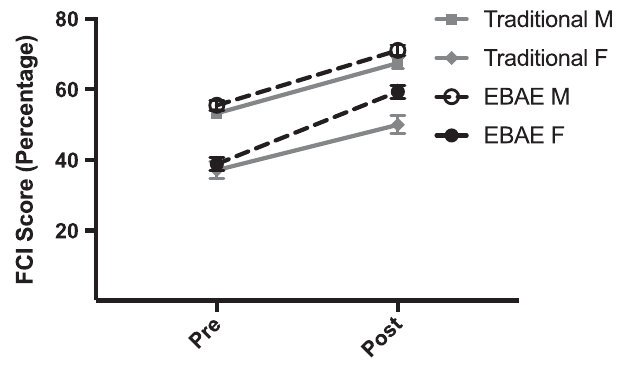
FIG. 7. Average FCI scores by gender and type of instruction. Average male student scores ( M ) are indicated by squares for traditionally taught male students (total number n ¼ 197 ) and open circles for the EBAE male students ( n ¼ 118 ). Average female student scores ( F ) are indicated by diamonds for tradi- tionally taught female students ( n ¼ 42 ) and closed circles for EBAE female students ( n ¼ 61 ). A gender gap that is significant is seen for both the traditional instruction and the EBAE instruction. Normalized gain for female students in EBAE classes compared with female students in traditional classes is sta- tistically significant ( p < 0 . 001